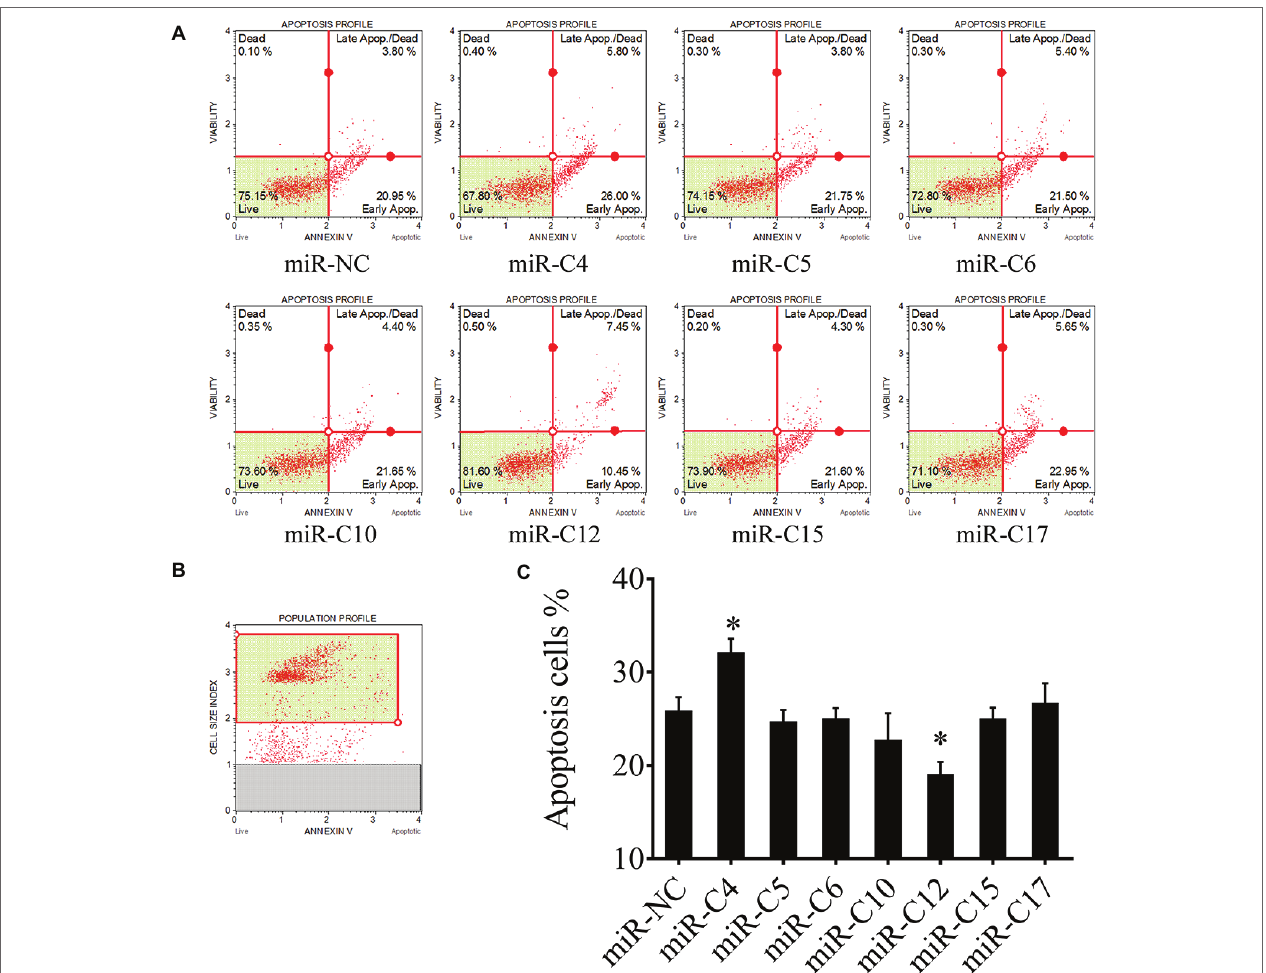
FIGURE 1 | Effect of viral miRNAs on CyHV-2-induced apoptosis. GiCF cells were infected with CyHV-2 (MOI = 0.1), transfected with eight different miRNA mimics 1 h post infection. Cell apoptosis at 24 h post-transfection was determined. (A) Apoptotic cells were quantified by flow cytometry at 24 h post-transfection. (B) Scatter plots of flow cytometry, cells in the red box were used for subsequent analysis. (C) Statistical the percentages of apoptosis. Data represent the means for three independent experiments, error bars are the standard errors. * p <